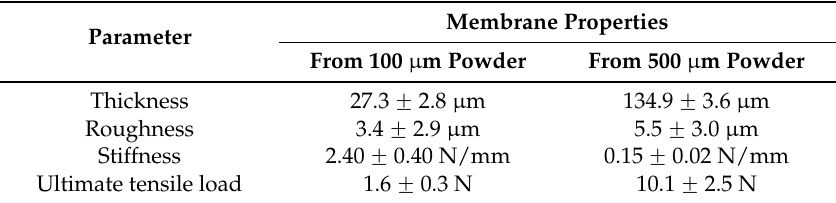
Table 2. Membrane characteristics and mechanical properties.